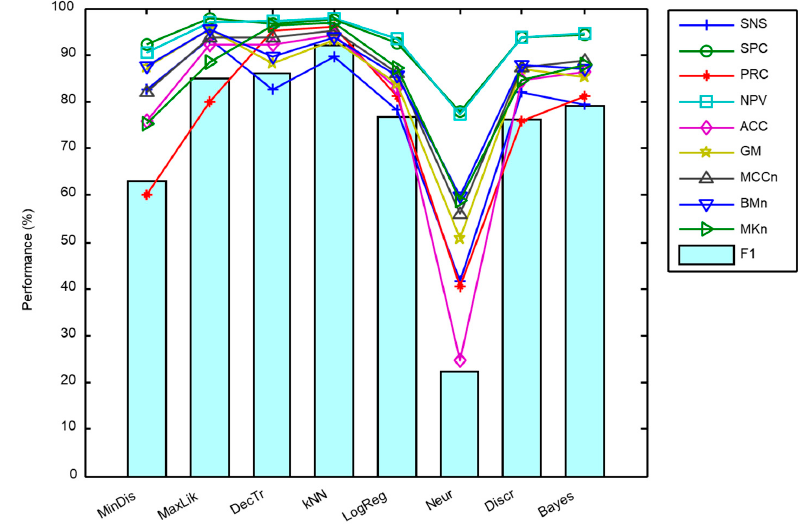
Figure 11. Performance metrics for the procedure of counting frames. Table 4. Performance metrics for the procedure of counting frames.